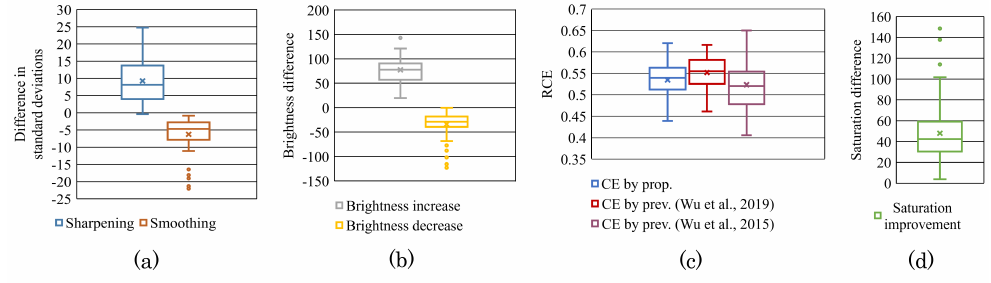
Figure 8. Maximum level of each evaluation index. ( a ) Difference in standard deviations. ( b ) Bright- ness difference. ( c ) RCE for proposed and previous methods [1,12]. ( d ) Saturation difference.